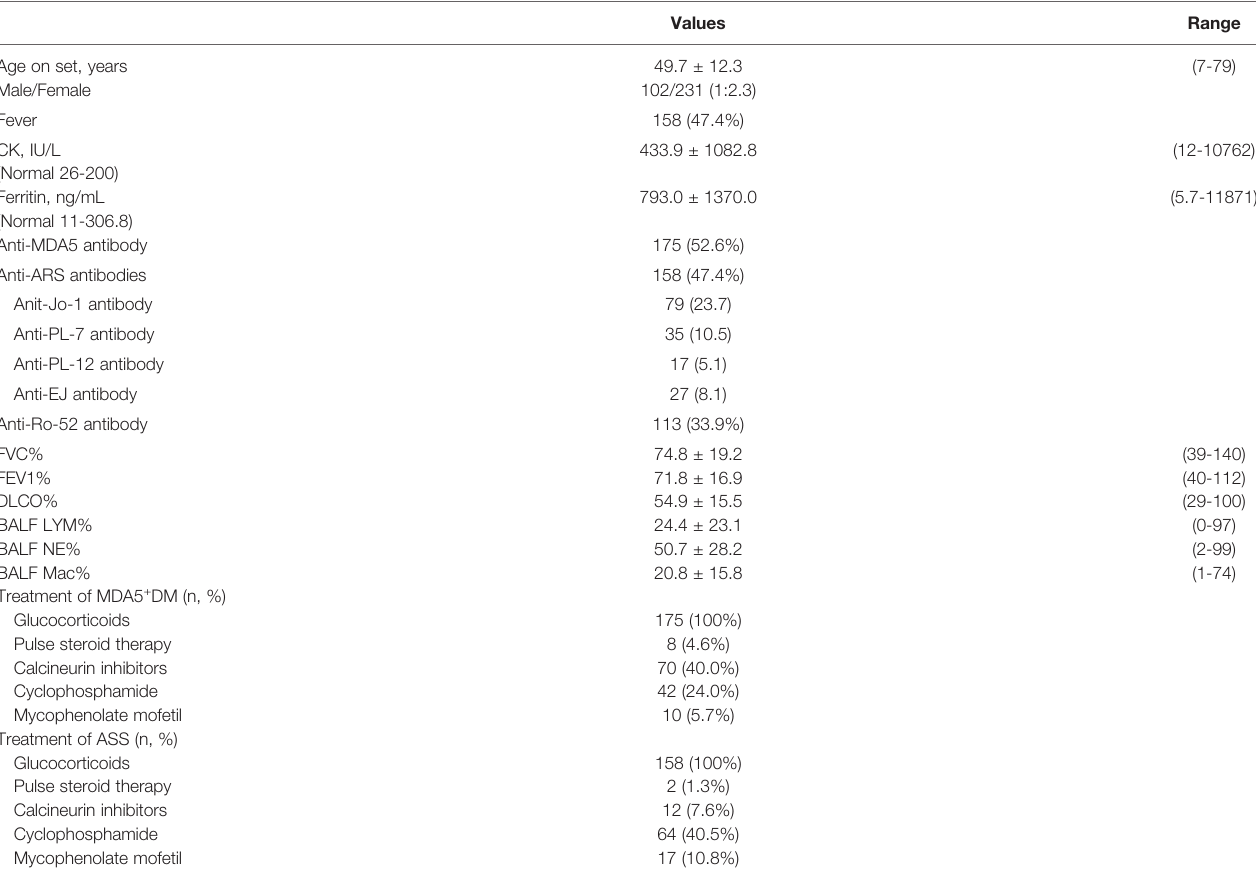
TABLE 1 | Characteristics of study participants at